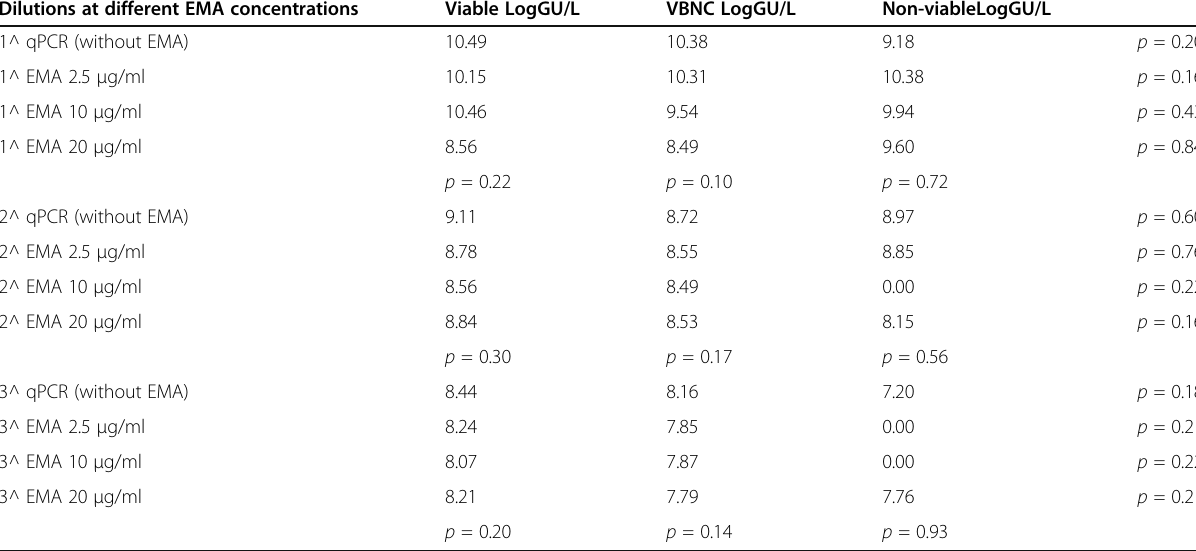
Table 2 Results of the experiments at the 3 dilutions of viable, VBNC and non-viable cells with EMA at different concentrations ( μ g/ml) Dilutions at different EMA concentrations Viable LogGU/L VBNC LogGU/L Non-viableLogGU/L 1^ qPCR (without